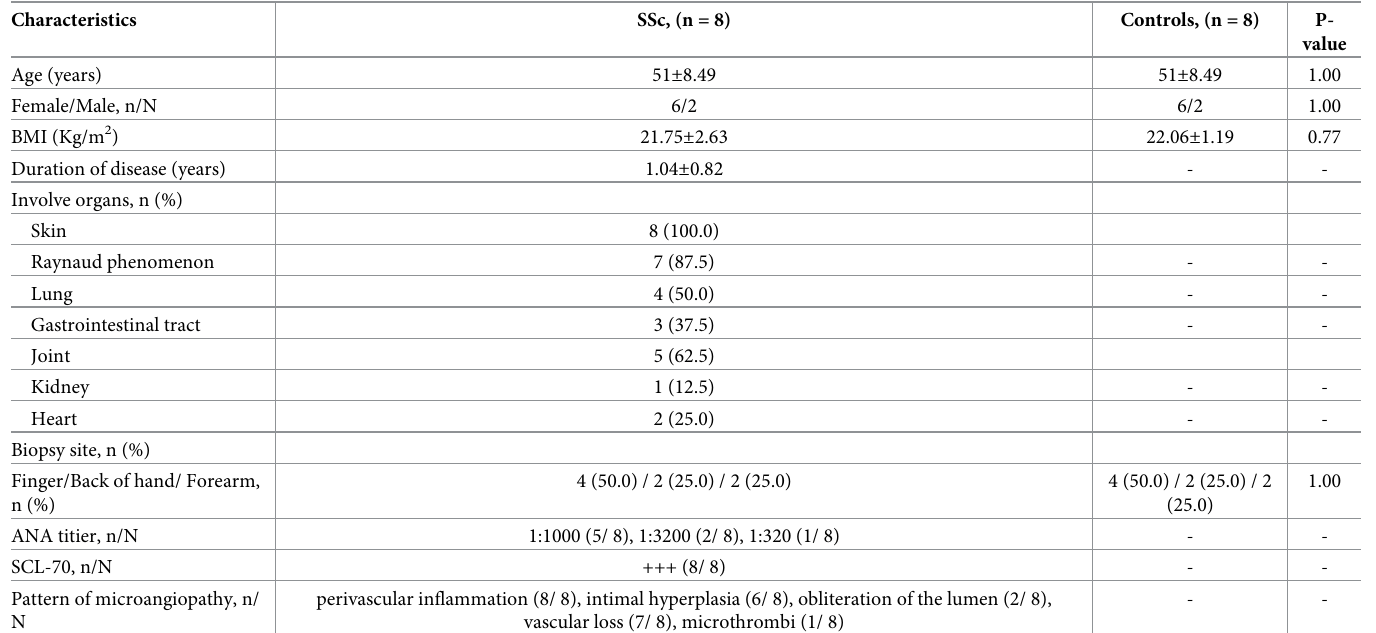
Table 2. Clinical and demographic characteristics of SSc patients and